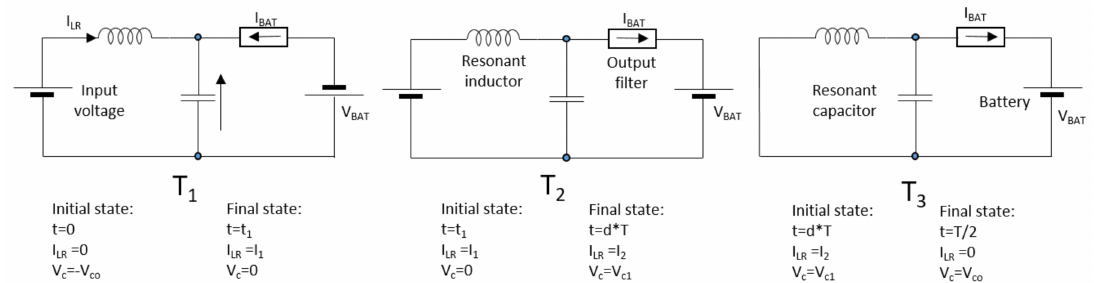
Figure 7. Equivalent circuits in the different stages, with initial and final state